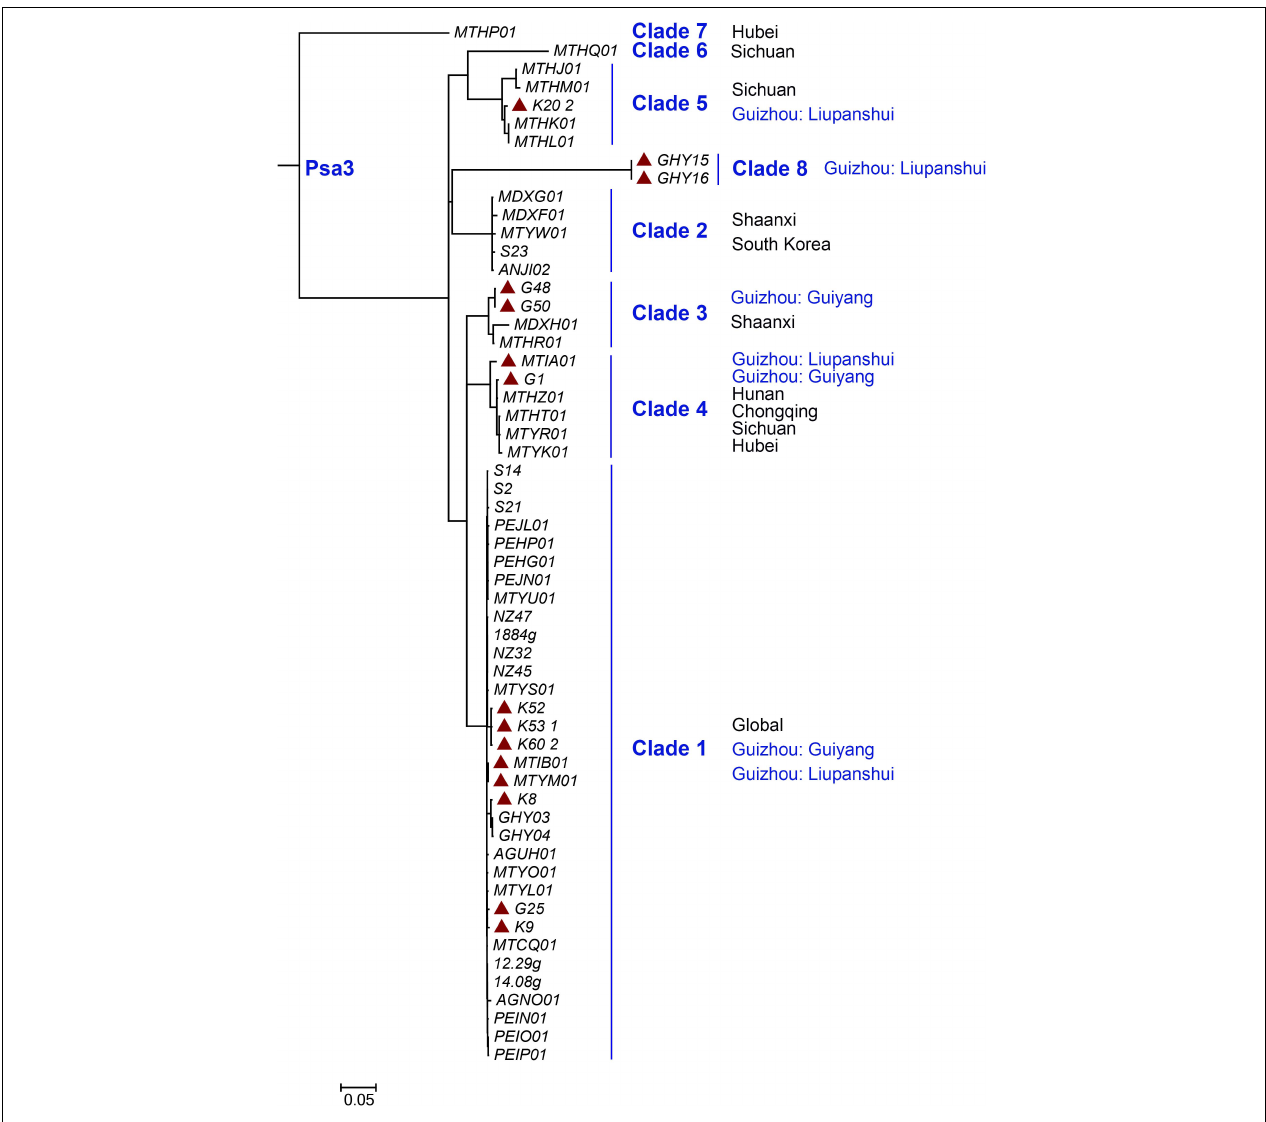
FIGURE 2 | Maximum likelihood tree of 57 representative isolates within Pseudomonas syringae pv. actinidiae biovar 3 (Psa3) based on whole genome data. The tree was built based on the bulk of non-recombination SNPs from Psa3 genome data using the panX pipeline (Ding et al., 2018). The red solid triangle indicates Psa3 strains from Guizhou Province,